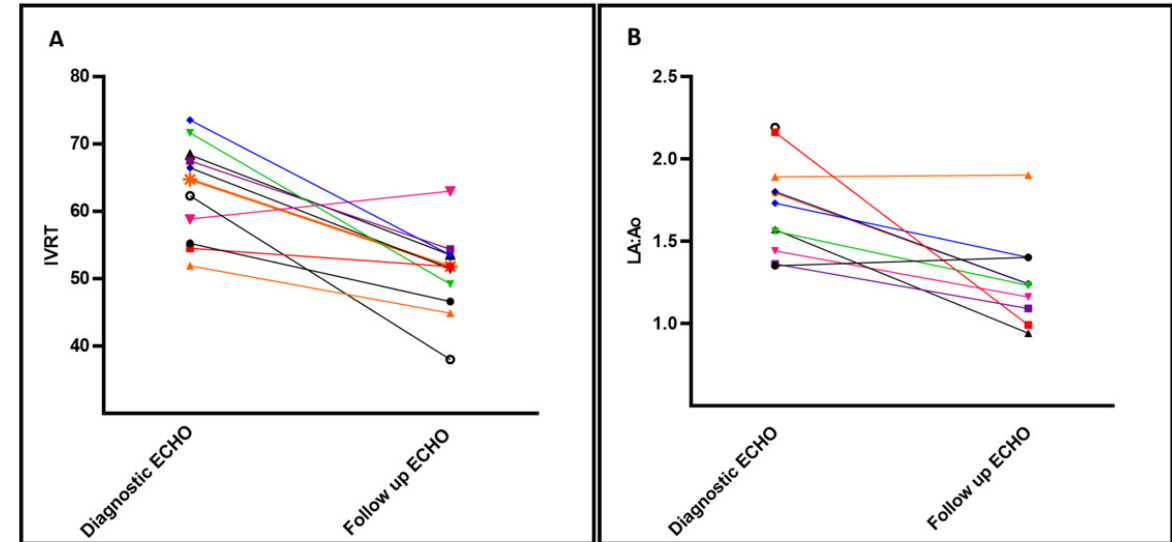
Figure 2. Select echocardiography indices of left heart diastolic function before/after enalapril treatment. Individual changes to Isoloumic Relaxation Time (IVRT) (Panel A ) and Left Atrium indexed to Aortic size (LA:Ao) (Panel B ) after treatment with enalapril, baseline shown at time of diagnostic ECHO vs Follow up ECHO prior to discharge. Each patient is represented in a different color and vignette.